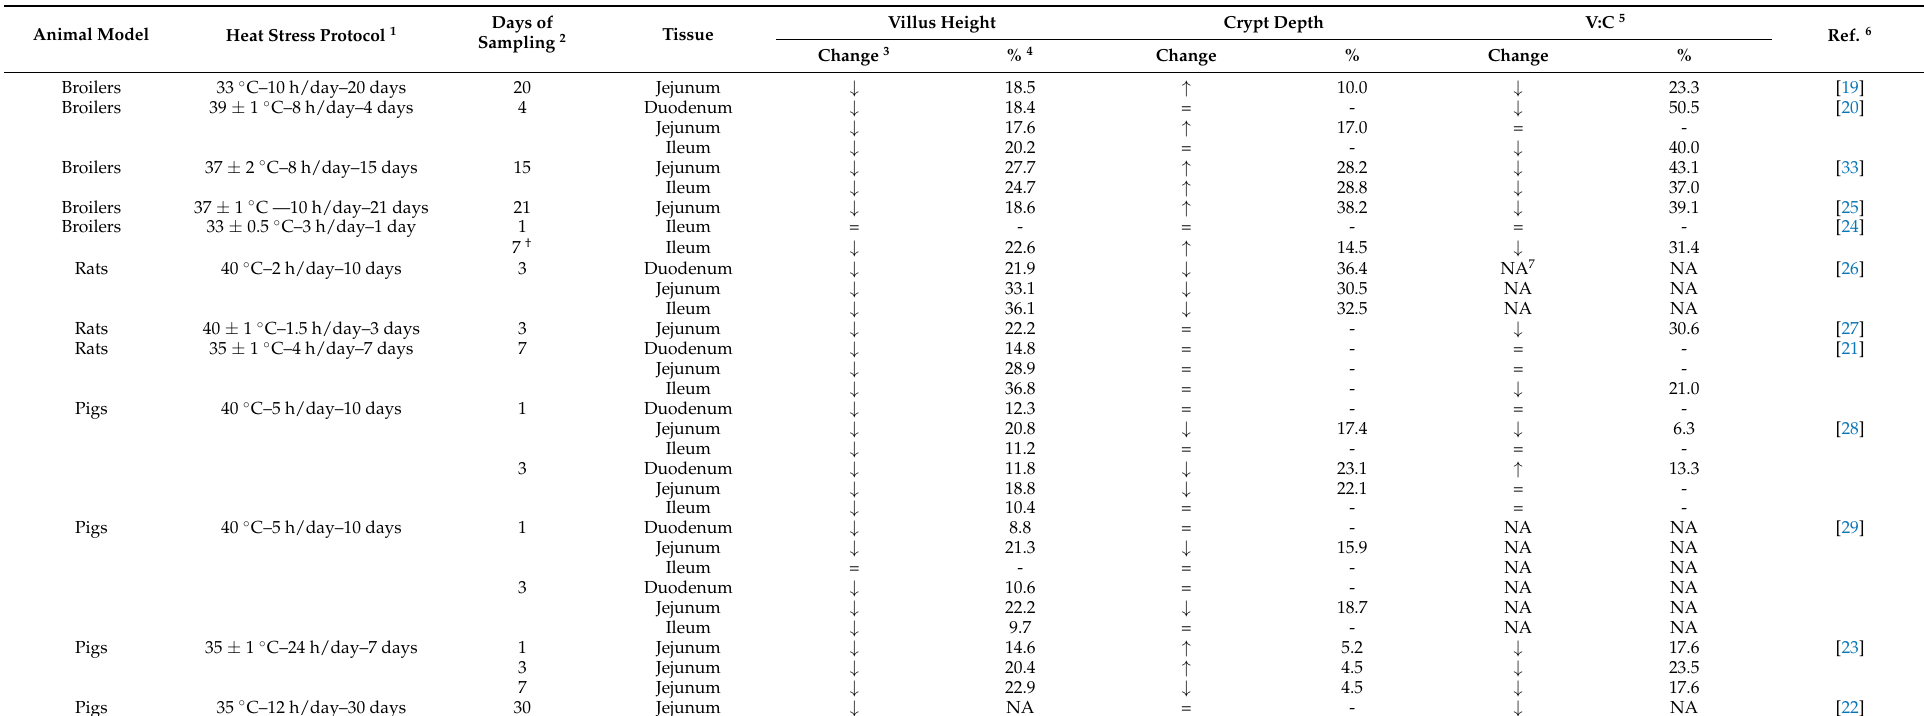
Table 1. Structural changes in the intestinal epithelium of different animals subjected to